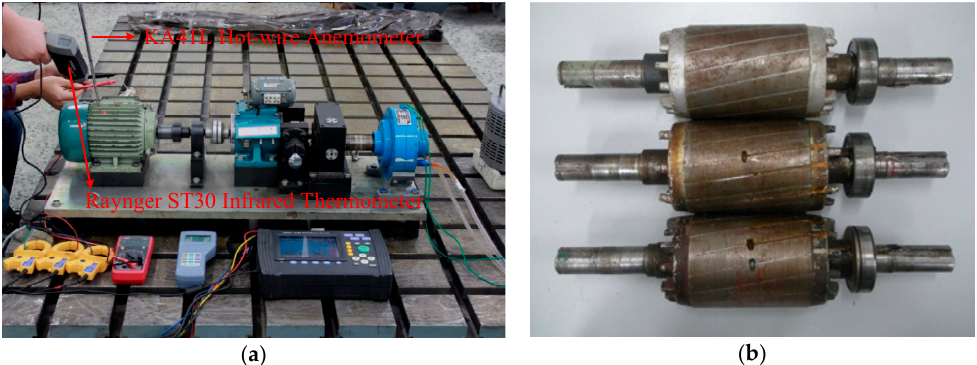
Figure 1. The laboratory test setup and the broken bar rotors: ( a ) The laboratory test setup; ( b ) the broken bar rotors. Table 1. Basic parameters of the prototype motor.